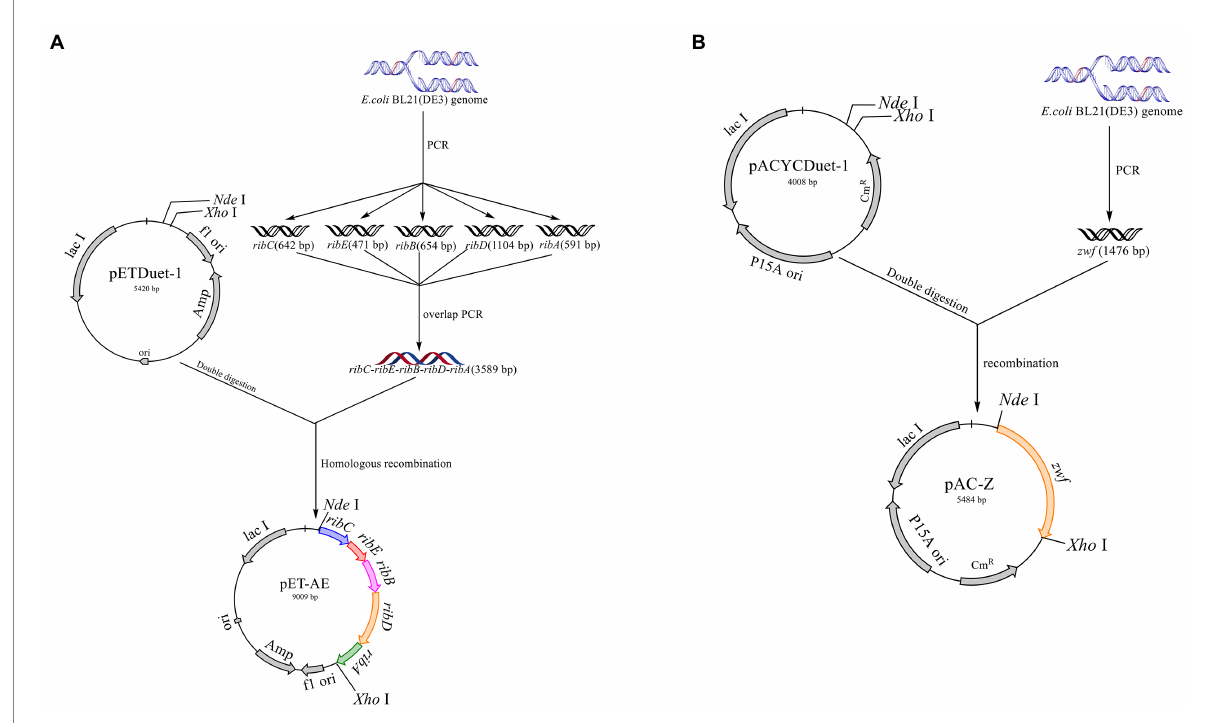
FIGURE 3 Schematic map of the construction of the plasmids pET-AE and pAC-Z. (A) Construction of the plasmid pET-AE; (B) the construction of the plasmid